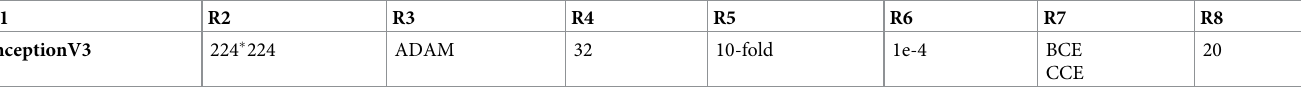
Table 4. Hyper-parameters of the InceptionV3 model and preferred weights in this study.